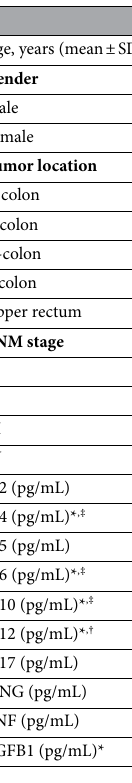
Table 1. Clinical characteristics and peritoneal cytokine concentrations § according to peritoneal cancer burdens. (143 patients). A ascending, T transverse, D descending, S sigmoid, IL interleukin, IFNG interferon gamma, TNF tumor necrosis factor, TGFB1 transforming growth factor beta 1. *p < 0.005, Kruskal–Wallis test for pT3 or less vs. pT4 vs. M1c. † p < 0.0025, Bonferroni adjusted p-value by Mann–Whitney U test for pT3 or less vs. pT4 (reference), two-tailed. ‡ p < 0.0025, Bonferroni adjusted p-value by Mann–Whitney U test for pT4 (reference) vs. M1c, two-tailed. § Median value (first quartile, third